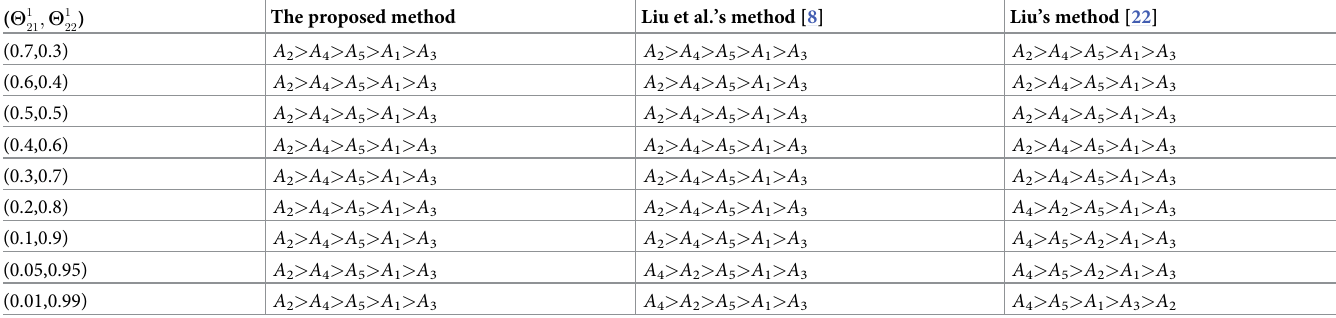
Table 13. The ranking results of the three